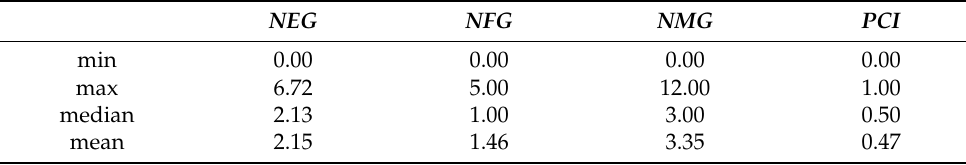
Table 1. Basic descriptive statistics of the pedigree ( n =